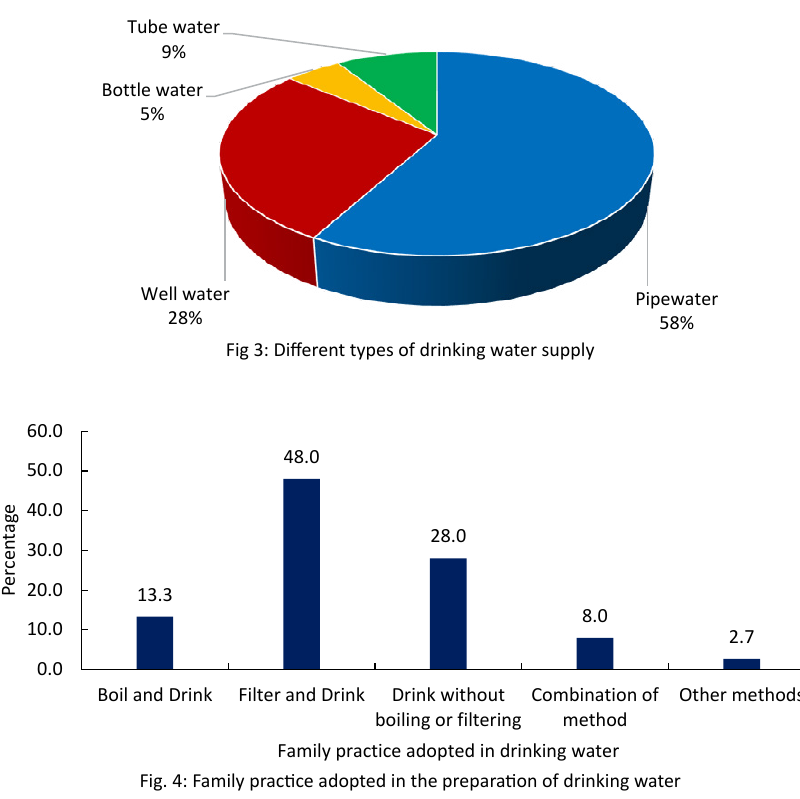
Fig. 4: Family practice adopted in the preparation of drinking